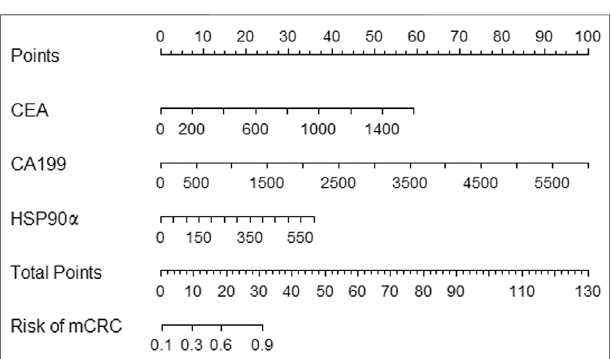
FIGURE 4 | Nomogram for predicting the presence of metastasis in patients with colorectal cancer.